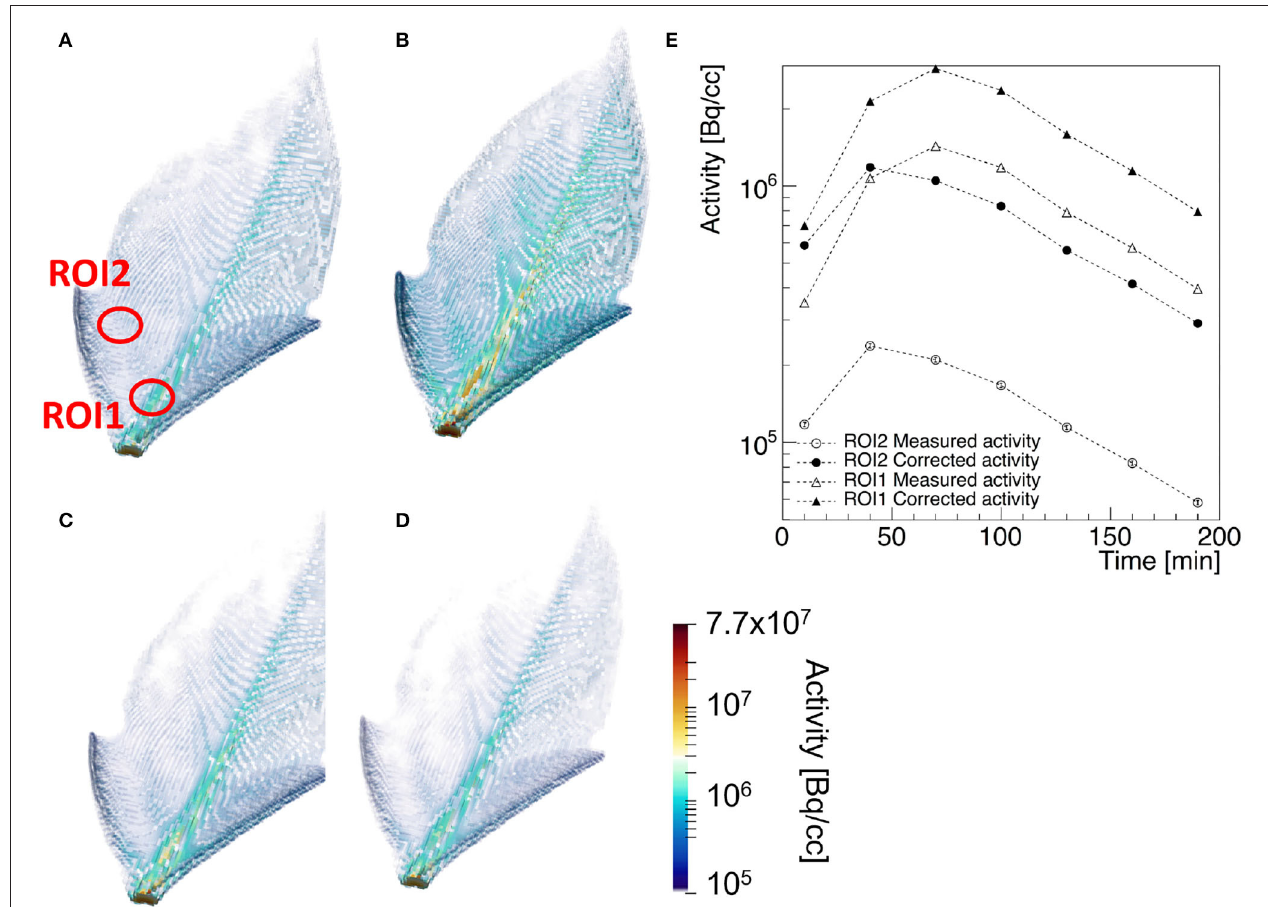
FIGURE 5 | Example of a [18]F-FDG PET of a leaf of Epipremnum Aureum: 3-dimensional view of the corrected tracer concentration 10 min (A) , 70 min (B) , 130 min (C) , and 190 min (D) after the beginning of the scan. The average standard uptake value of the measured (empty markers) and corrected tracer distribution (filled markers) in the two ROIs identified in (A) are shown in (E) as a function of the acquisition time.